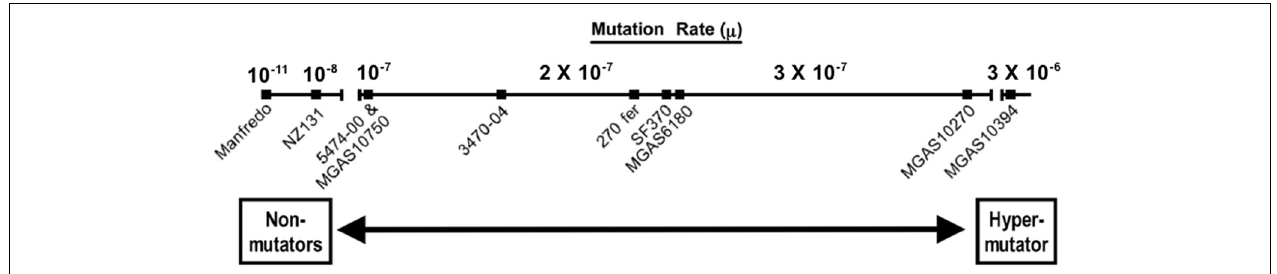
FIGURE 2 | The mutation rates of SpyCI + S. pyogenes genome and clinical strains. Strains harboring SpyCI integrated into mutL have phenotypes that range from non-mutator in Manfredo, where a novel CI promoter in the defective integrase gene rescues expression of mutL , to a